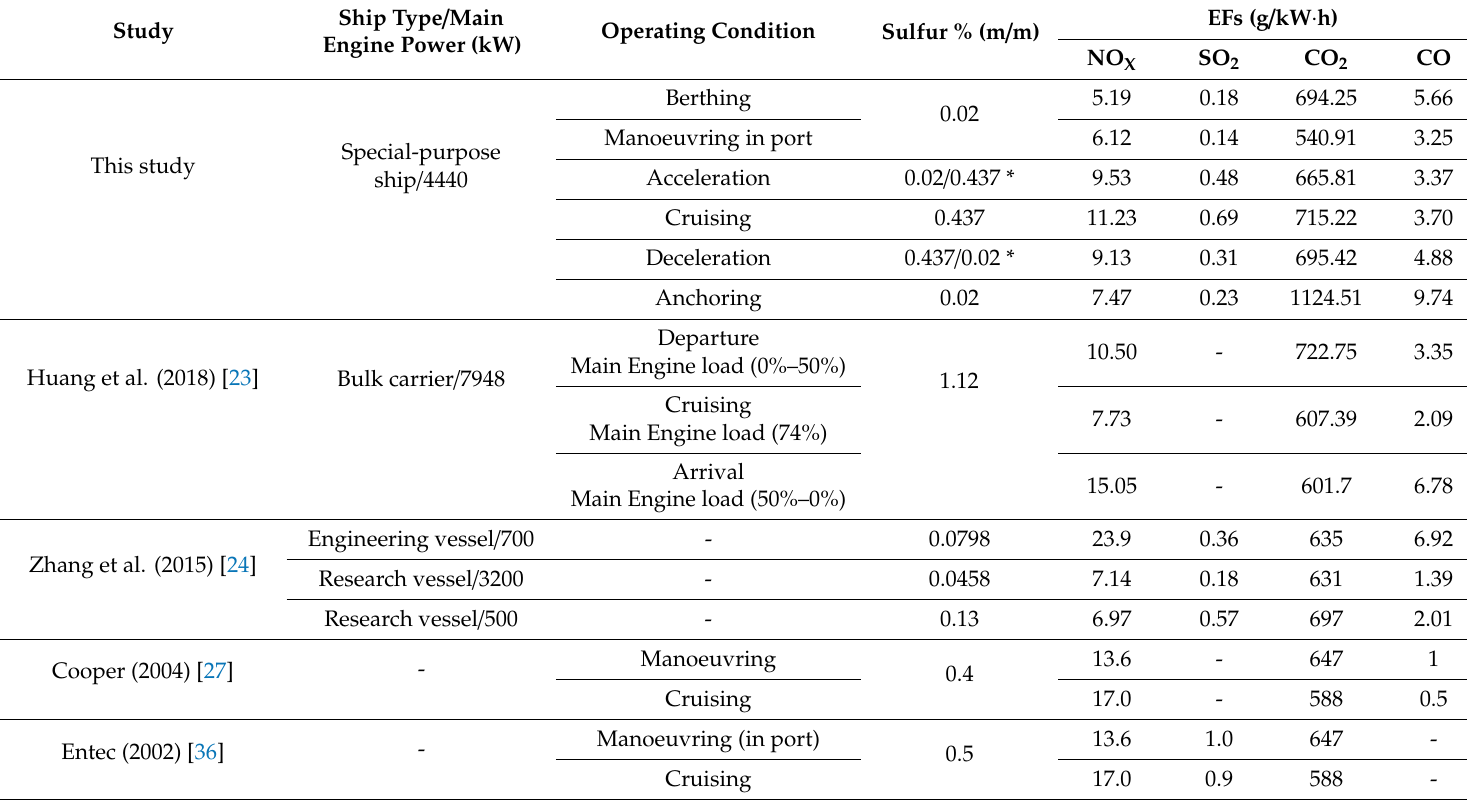
Table 4. Comparison of the average emission factors based on the main engine